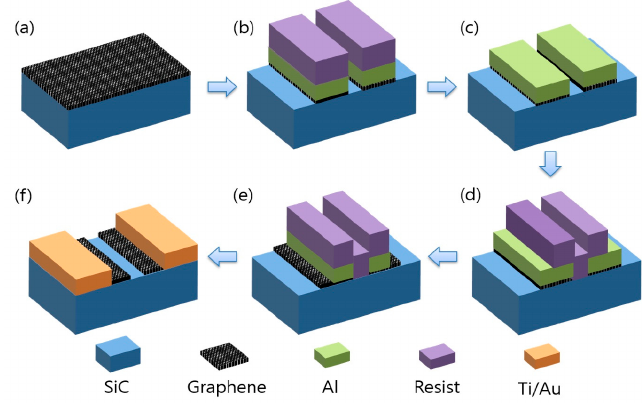
Figure 1. The schematic illustration of the fabrication process of the G/SiC electrode : ( a ) As-grown epitaxial graphene on SiC (G/SiC); ( b ) An aluminum protection layer was first deposited on G/SiC, and this was followed by electron beam lithography (EBL) and successive graphene etching in oxygen plasma; ( c ) Resist is removed with organic solvents; ( d ) A second EBL step for defining global Ti/Au contacts ( e ) Al removal by wet etching; ( f ) Deposition of Ti/Au global contacts on G/SiC electrodes and lift-off in organic solvents.